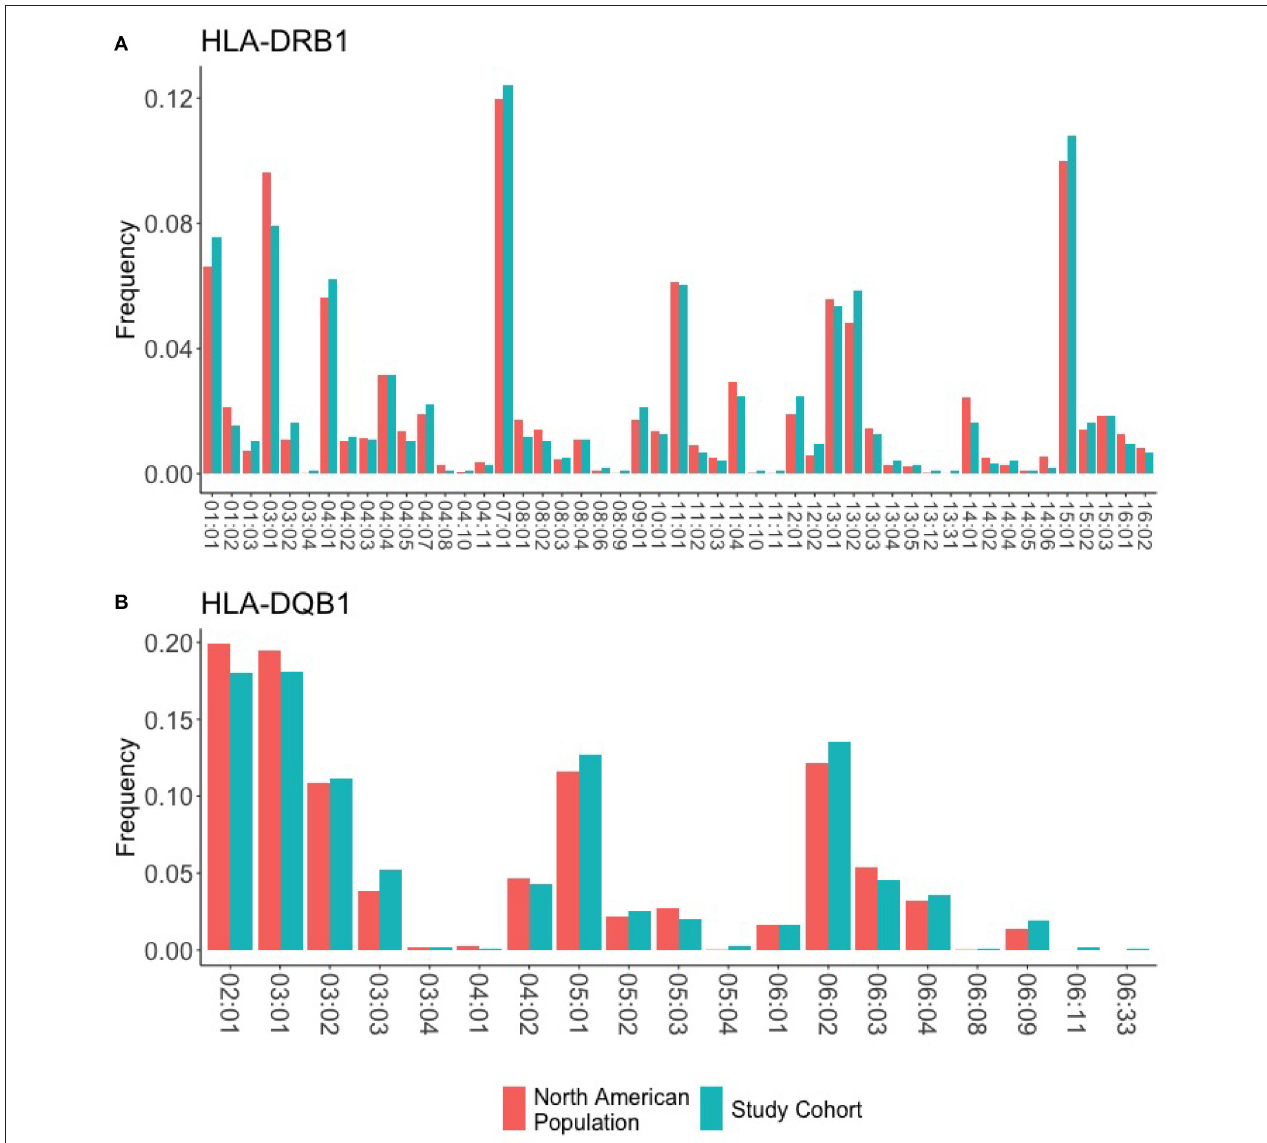
FIGURE 2 | HLA frequencies in the study cohort. HLA frequencies of the 997 participants are compared to the expected frequencies of the North American sub-population. (A) The frequencies of HLA-DRB1 alleles in the study cohort (green) closely match the background distribution of alleles in the whole North American population. (B) The frequencies of HLA-DQB1 alleles in the study cohort (green) closely match the background distribution of alleles in the whole North American population.